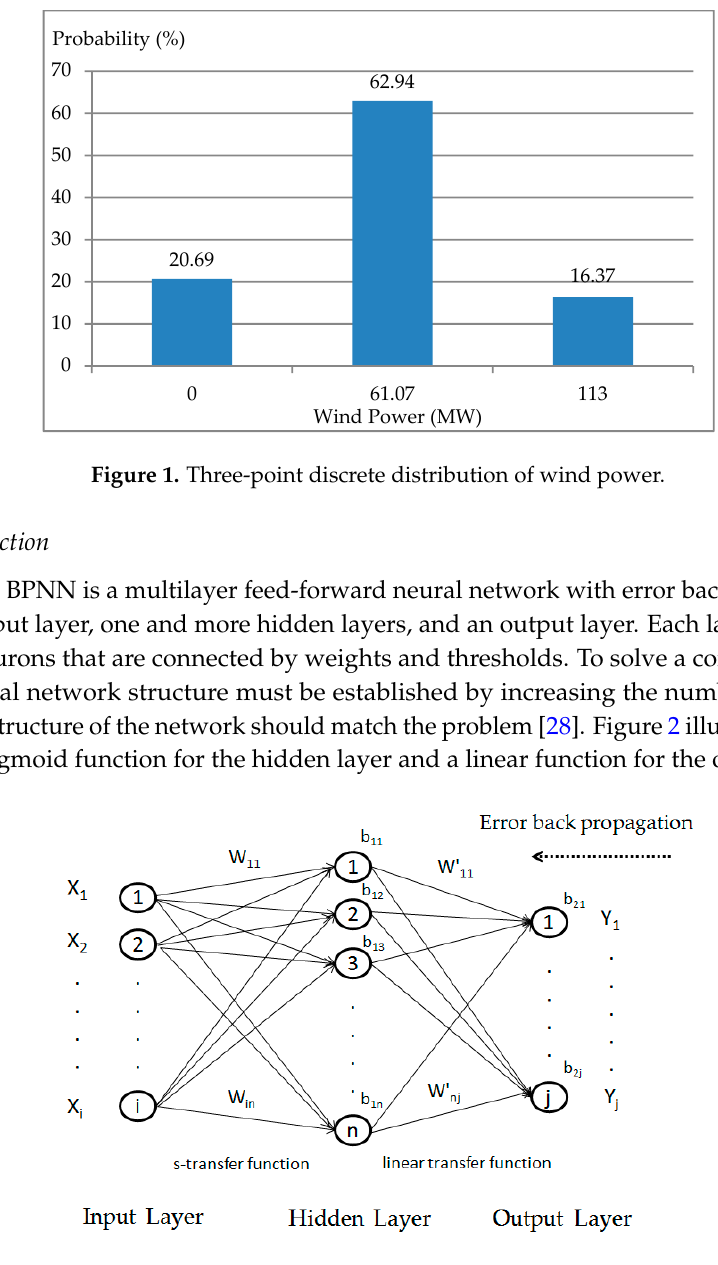
Figure 2. Basic structure of a back ‐ propagation network.